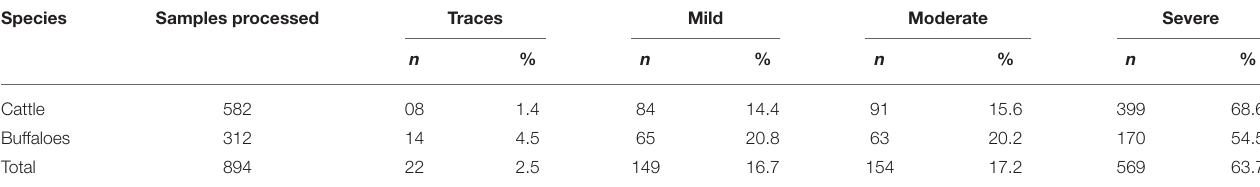
TABLE 2 | The severity of subclinical mastitis in cow and buffaloes.